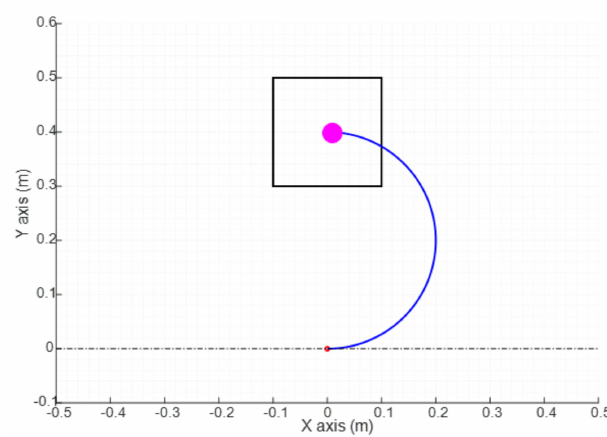
Figure 2. C-leg schematics positioned in the most upright position.